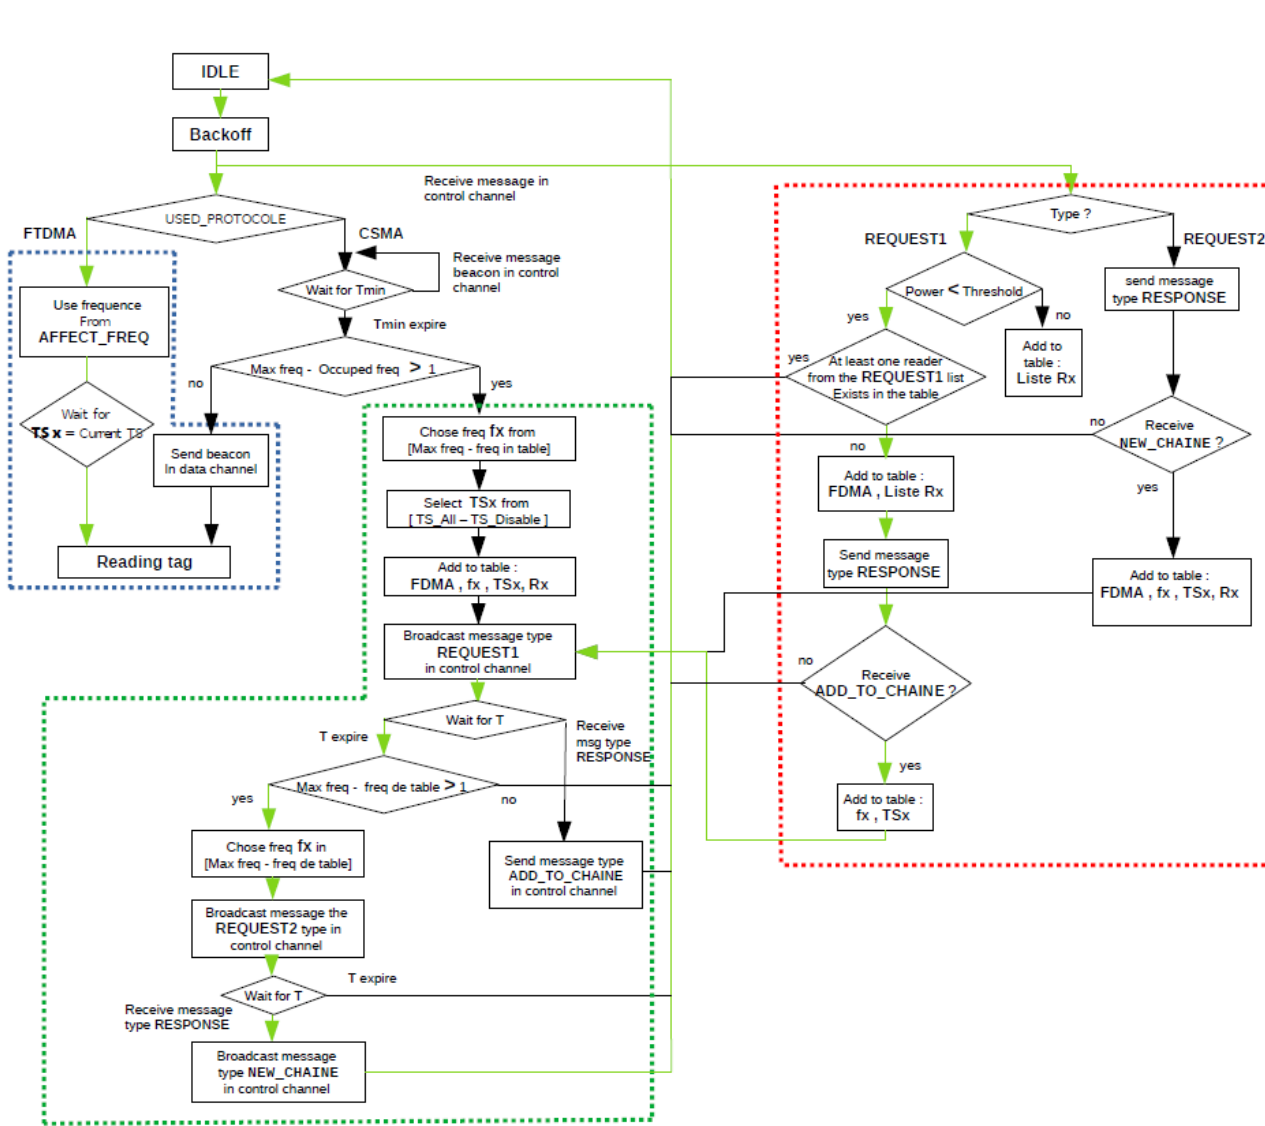
Figure A5. R8 Figure A5. R8 process.